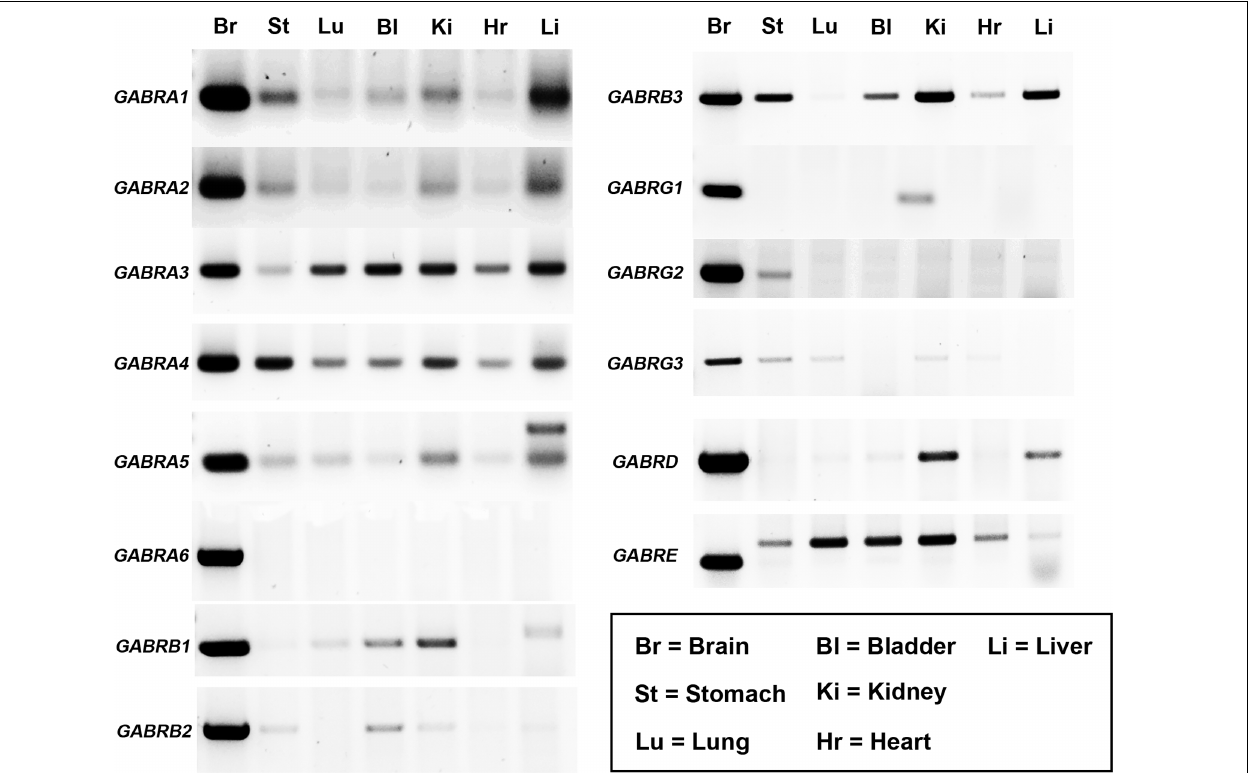
FIGURE 1 | Diversity of GABA A R subunit expression within various organs of the mouse. Representative gel electrophoresis images of mRNA transcripts for various GABA A R subunits using RT-PCR and homogenates from the whole brain (Br), stomach (St), lung (Lu), bladder (Bl), kidney (Ki), heart (Hr), and liver (Li) obtained from adult male C57BL/6 mice. Corresponding amplicons of the same size bands to those obtained from the brain were consistently detected for various GABA A R subunits within a number of peripheral organs. N = 3